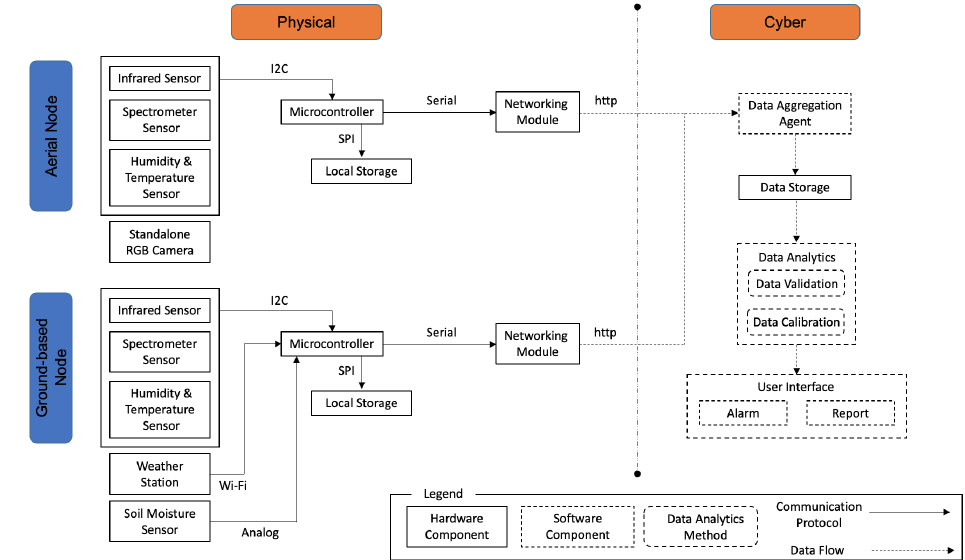
Figure 1. Architecture of HSP for IoT-based precision